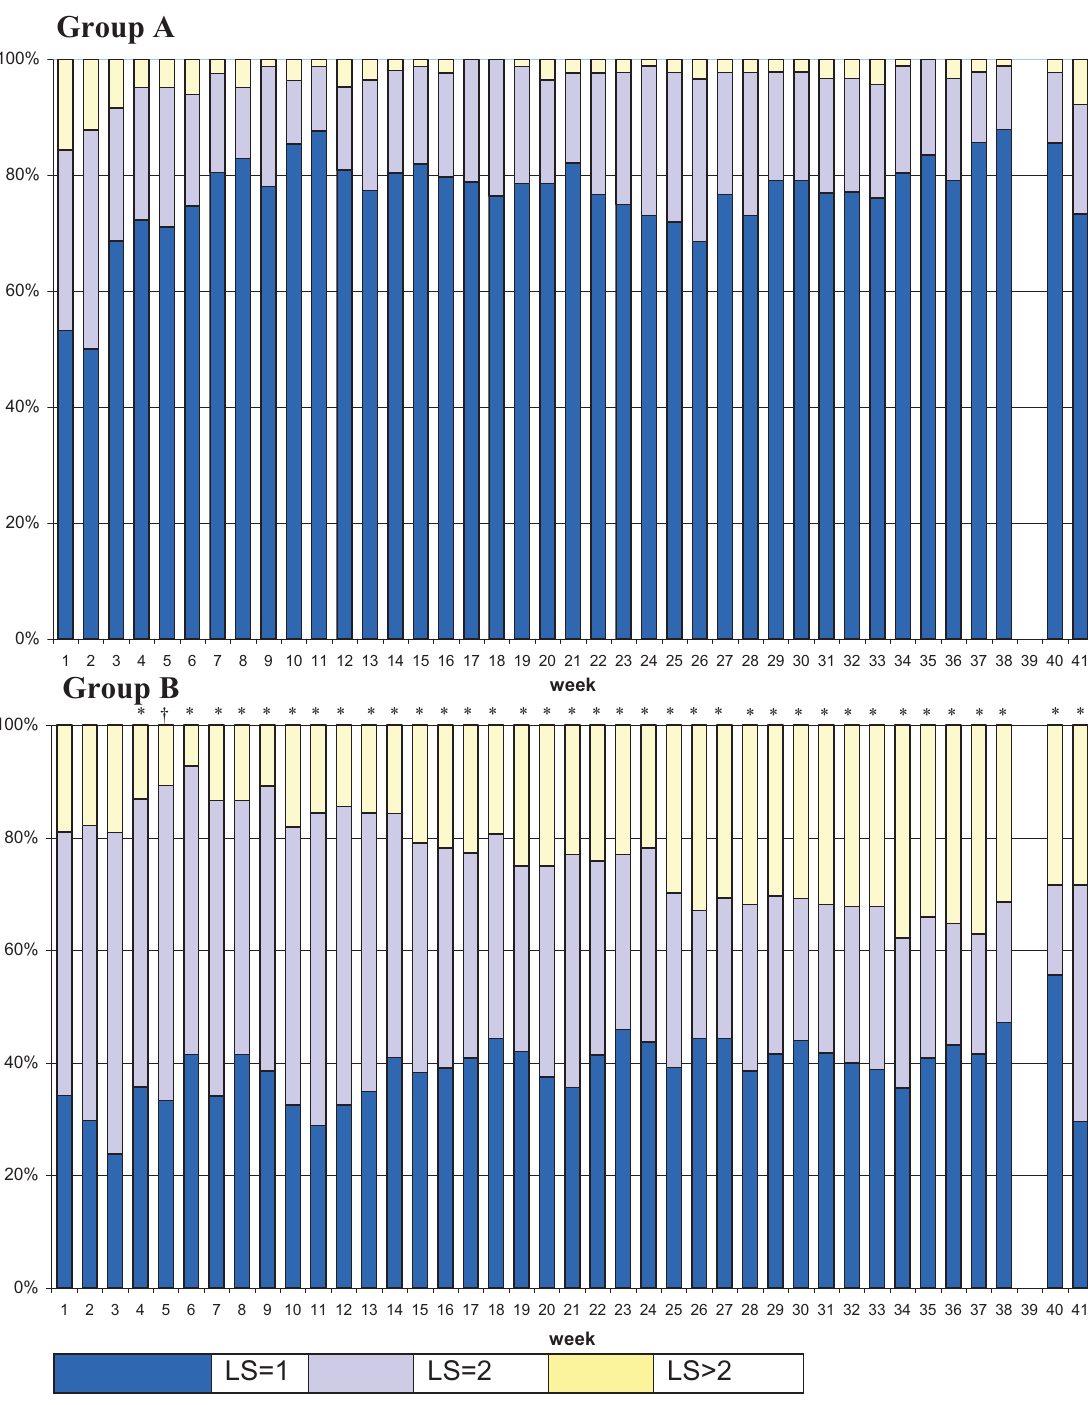
Figure 1. Distribution of cows in Group A and Group B among three locomotion score (LS) classes throughout a 41-week experimental